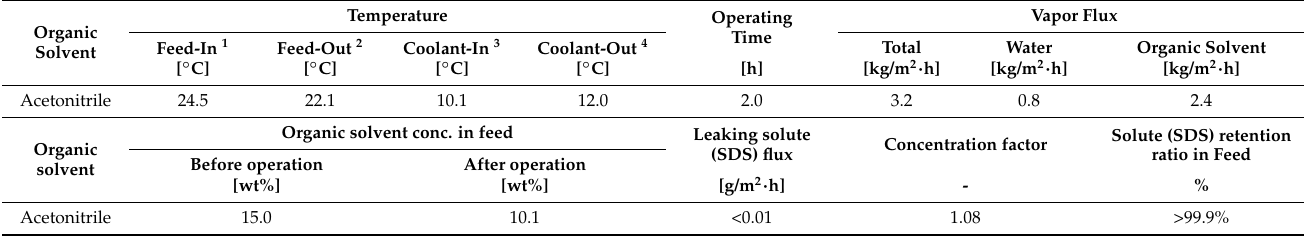
Table 9. Results of DCMD operation at 25 ◦ C with the feed which contains 1000 ppm SDS and 15wt% of acetonitrile. Organic